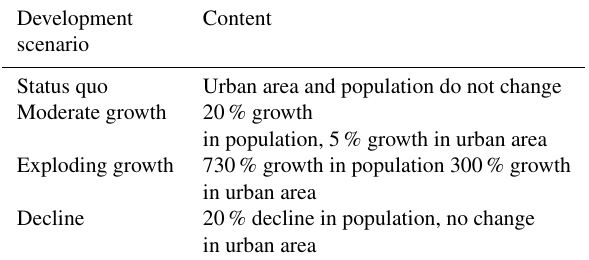
Table 2. Socio-economic development scenarios for